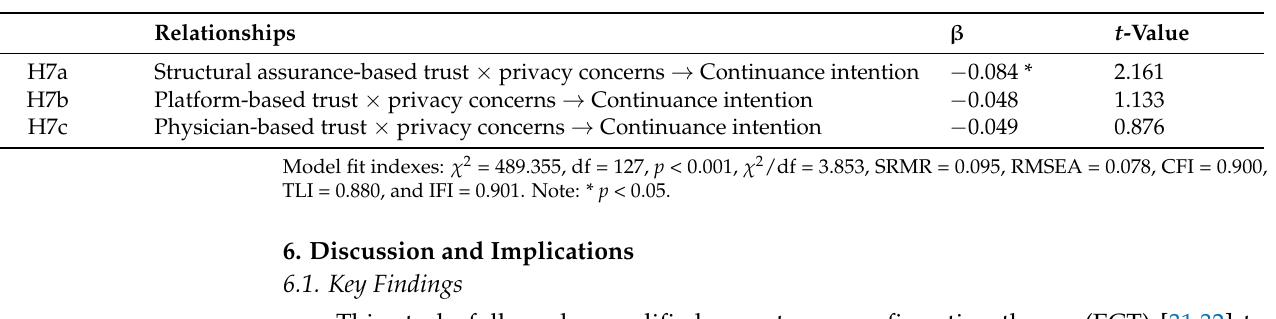
Table 5. Results of the moderation